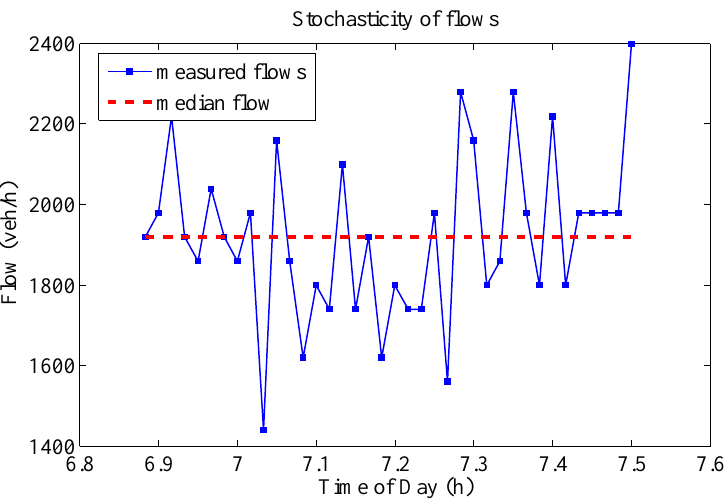
Figure 3. The fluctuation of the capacity flow for one incident For the same incident location, Figure 1 shows the construction of the reference capacity. The